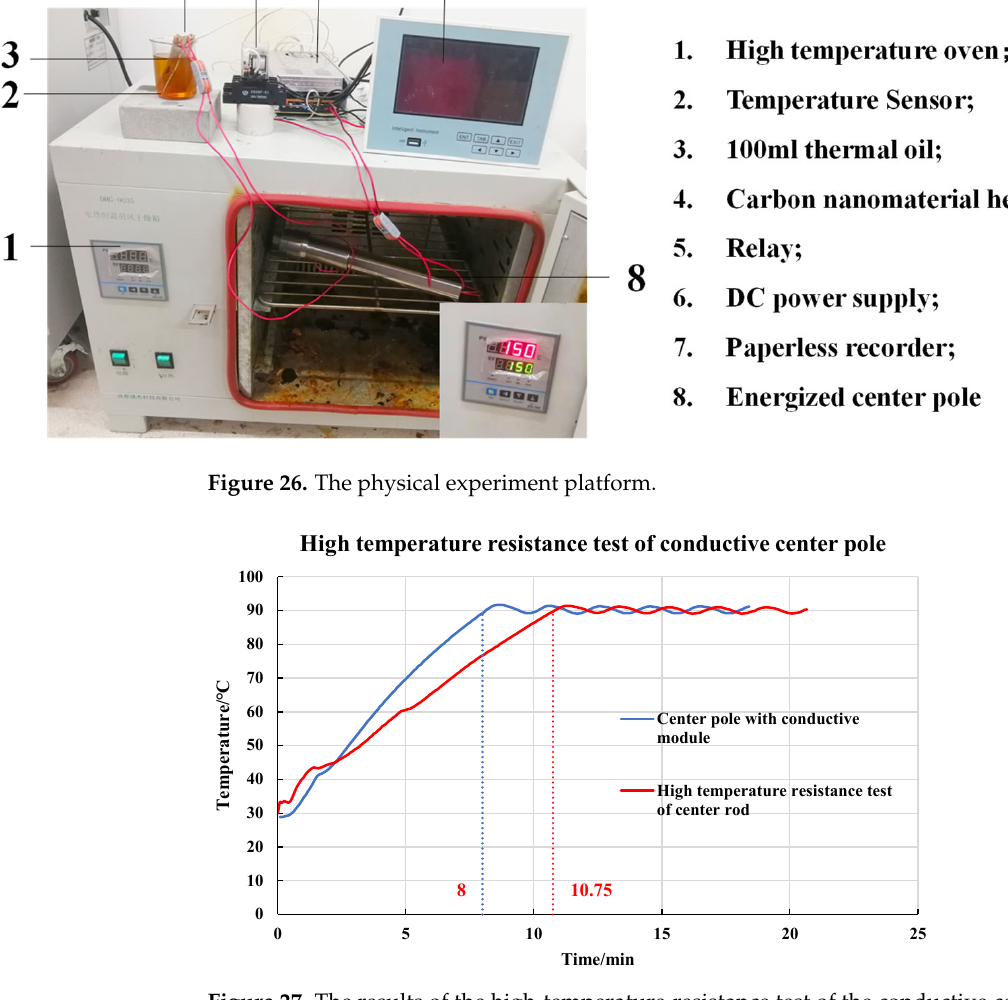
Figure 28. Long-term experiment and results of the stability of the energy supply by the conducting central rod. In addition, the signal transmission performance of the conductive central rod was verified by experiments. First, the signal transmission of the PT100 temperature sensor